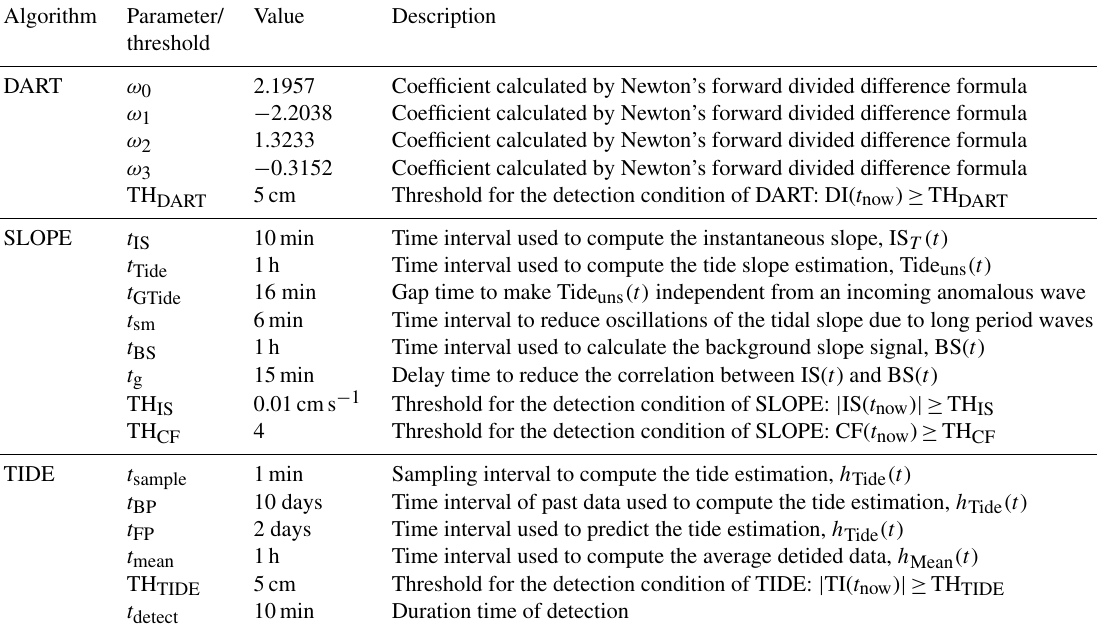
Table 4. Parameters and thresholds of a tsunami detection algorithm.